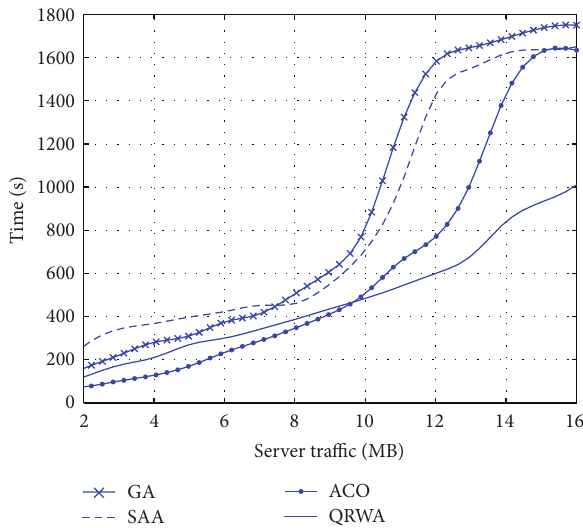
Figure 3: The server traffic of SUN SPARC Enterprise T5120 in GA, SAA, ACO, and QRWA.